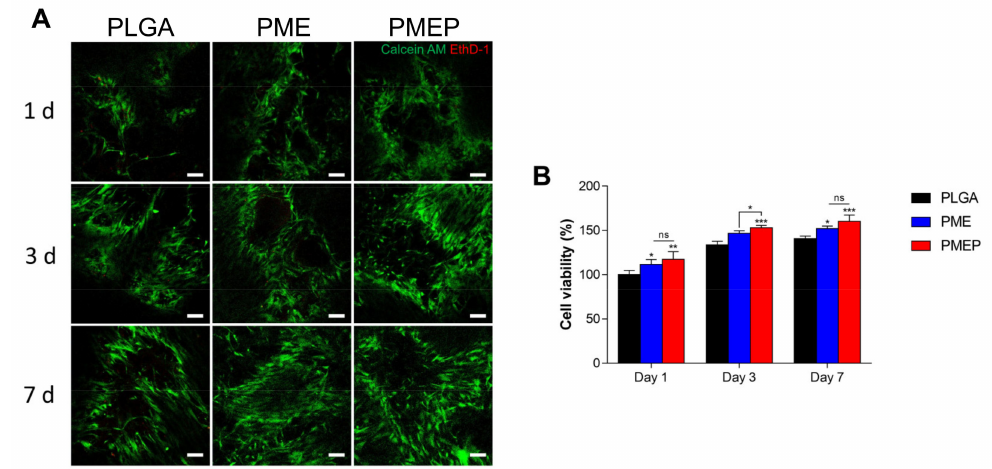
Figure 2. Biocompatibility of the scaffolds. ( A ) live-dead assay images on each scaffold at 1, 3, and 7 days (scale bar = 100 µ m). ( B ) cell viability of the hBMSCs onto each scaffold at 1, 3, and 7 days in vitro. The differences were considered significant when ns = not significant ( p ≥ 0.05), * p < 0.05, ** p < 0.01, and *** p < 0.001 ( n ≥